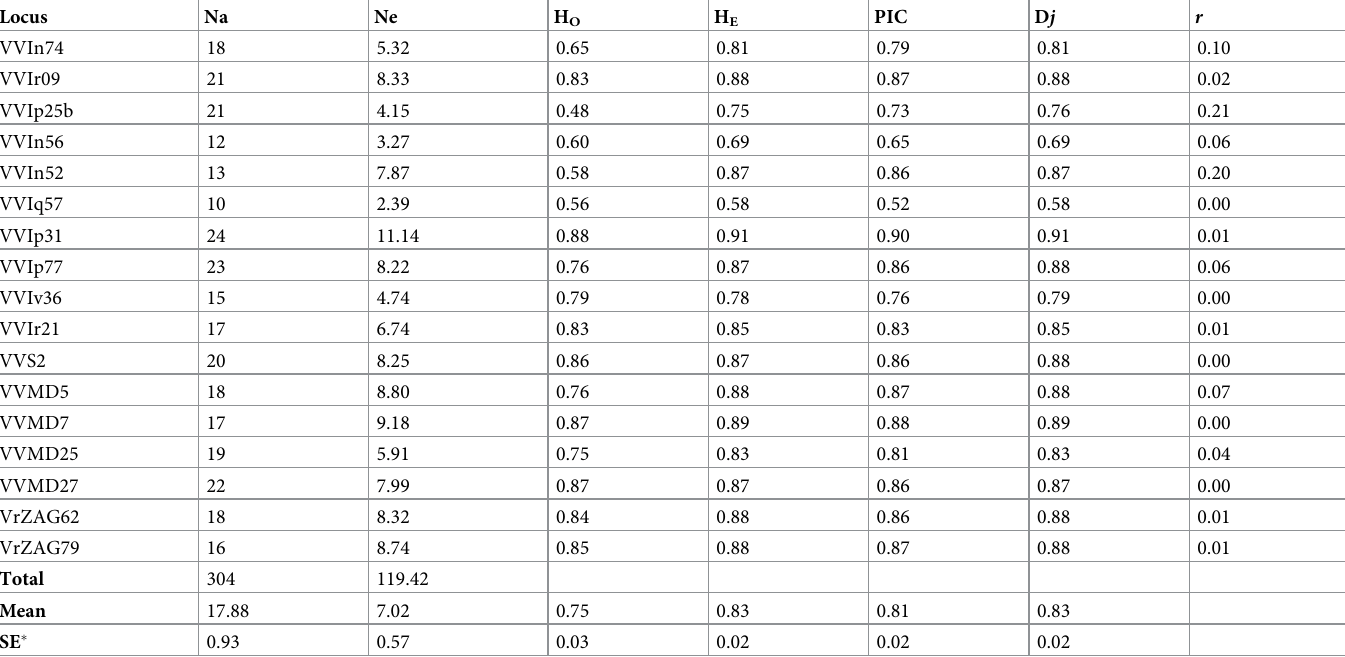
Number of alleles (Na), number of effective alleles (Ne), observed heterozygosity (H O ), expected heterozygosity (H E ), polymorphic information content (PIC), discrimination power (D j ), estimated frequency of null alleles ( r ). � Standard error of mean